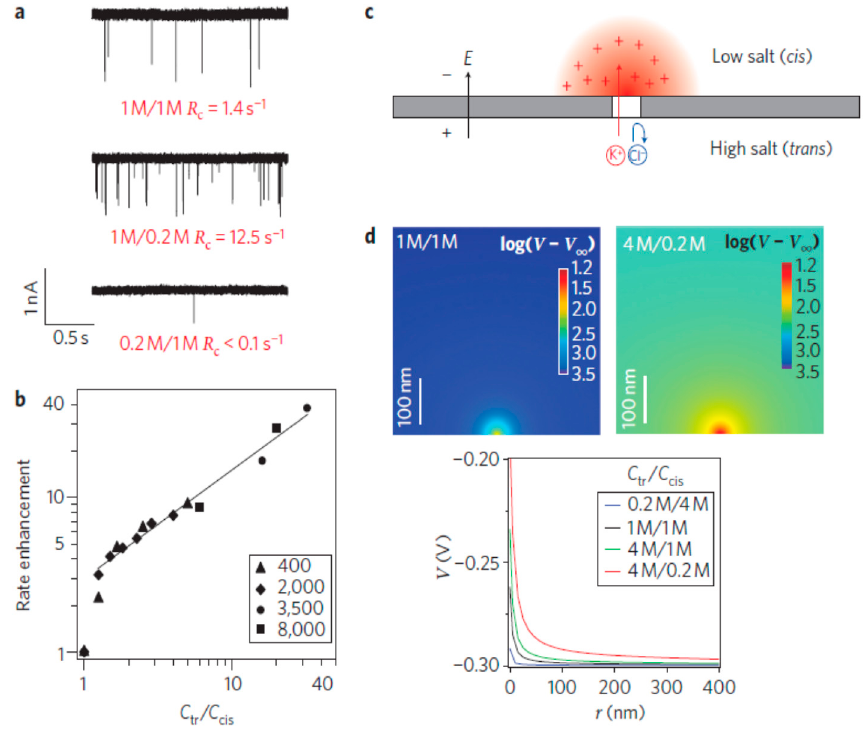
Figure 14. Intensified DNA molecules focusing into a solid-sate 3.5-nm nanoscale pore by salt gradients. ( a ) Measured continuous traces with 400 bp DNA for different KCl concentration ( C tr / C cis ) ratios. R c value in each case is the average capture rate; ( b ) enhancement of DNA capture rate with C tr / C cis for four different DNA lengths; ( c ) schematic showing of the selective transport of cations (K + ) from trans to cis for the case of C tr / C cis > 1, leading to a local accumulation of cations near the pore on the cis side (reddish area), which enhances capture rate; ( d ) numerical electric potential distributions around the pore at the cis side, for both symmetric (top left) and asymmetric (top right) KCl concentrations. The bottom center of each image is where the pore is located. Reprint from Ref. [172].